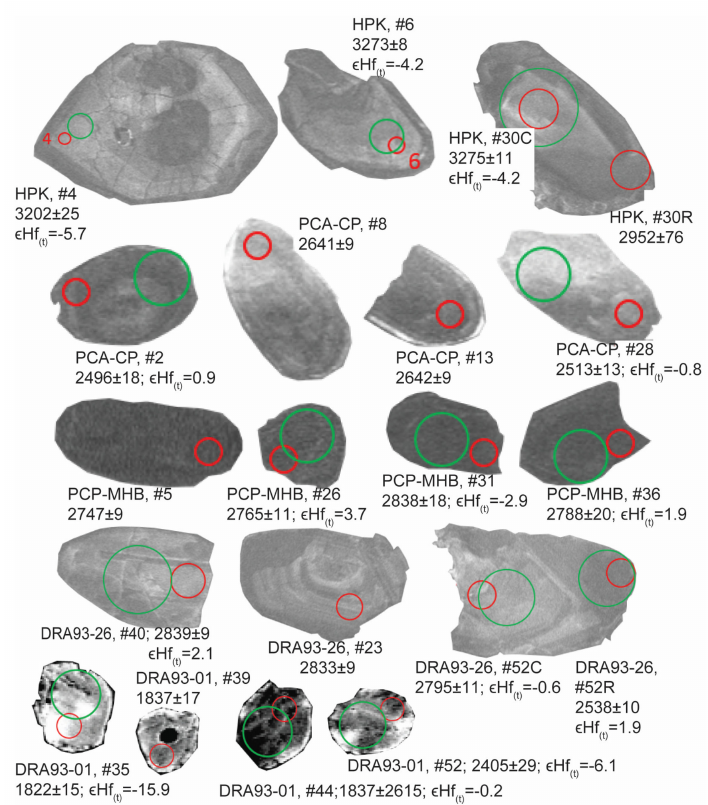
Figure 2. Representative CL images of analyzed zircon. Red smaller circles represent 20 µ m U-Pb analysis spots. Green larger circles represent 40 µ m Lu–Hf analysis